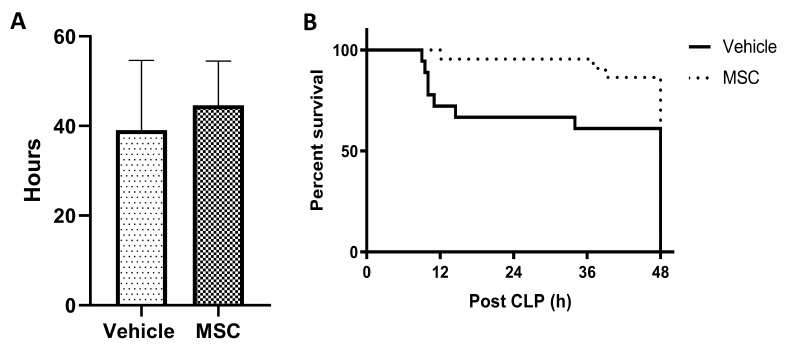
Figure 2. Survival after severe caecal ligation and puncture (CLP) injury and CD362 + UC-MSC administration. Administration of CD362 + UC-MSCs contemporaneous with severe systemic sepsis induction increased mean survival duration ( A , n = 32 / 14) and total survival at the defined 48 h timepoint ( B ). Bars represent mean ( n = 32 / 14), error bars represent SD.